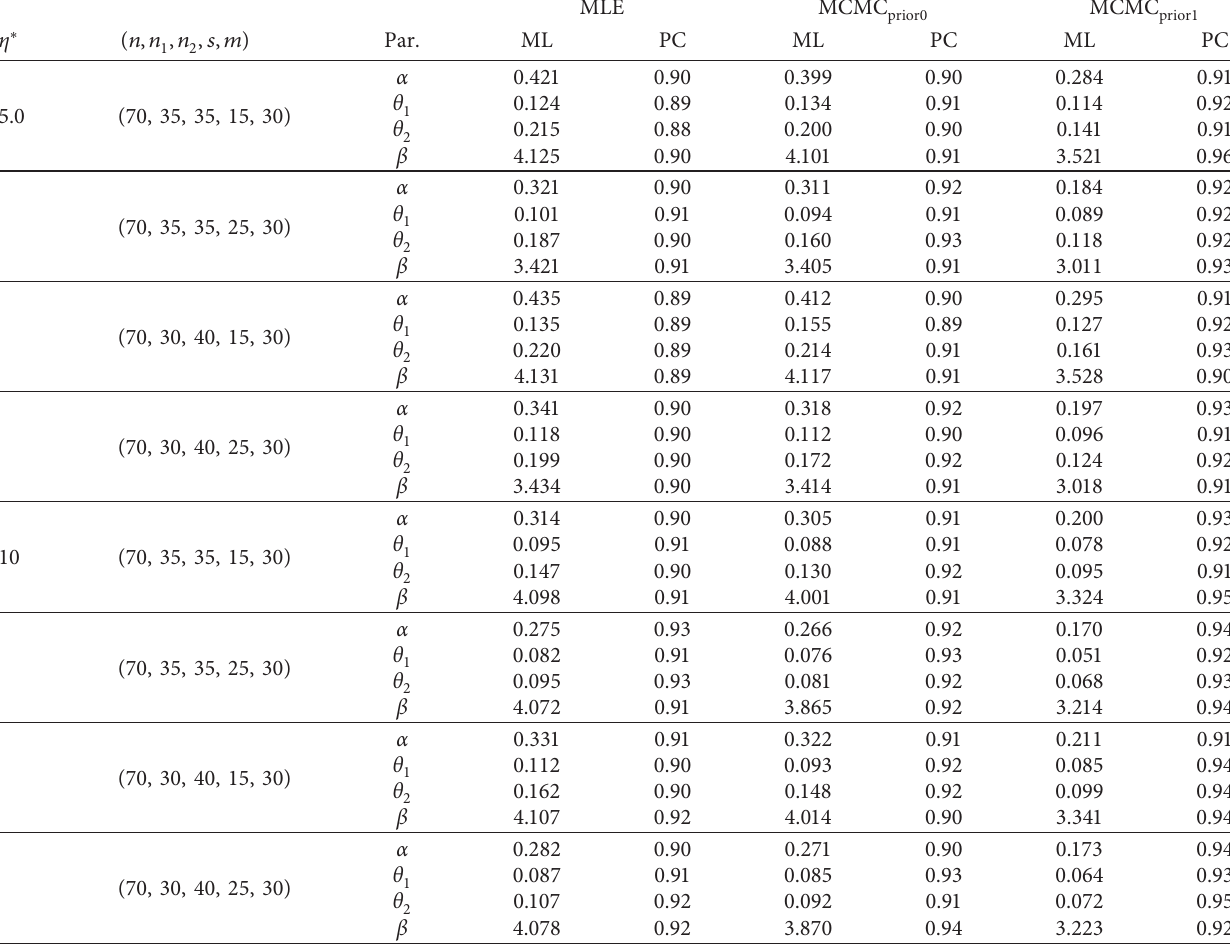
, θ , β ) � ( 0 . 1 , 0 . 05 , 0 . 08 , 2 . 0 ) . 1 2